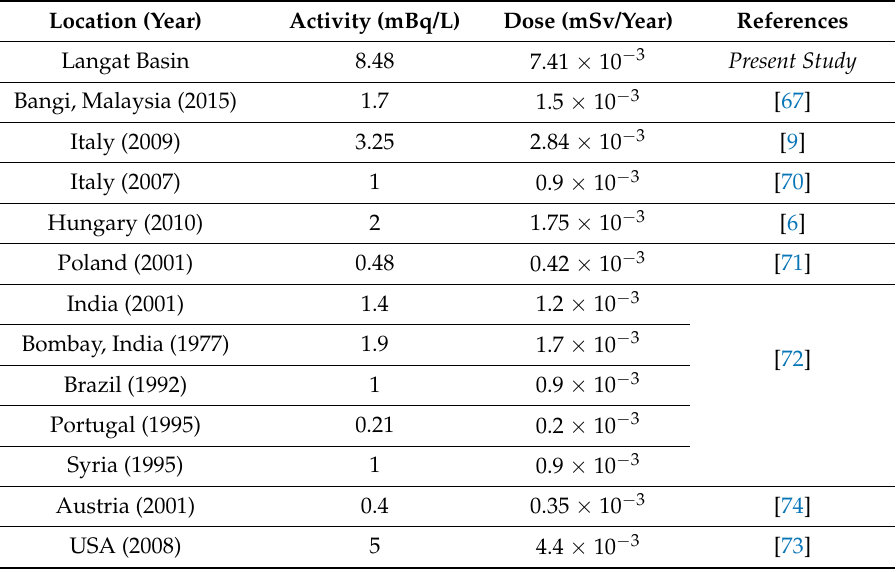
Table 9. Po-210 activity in household’s tap water around the